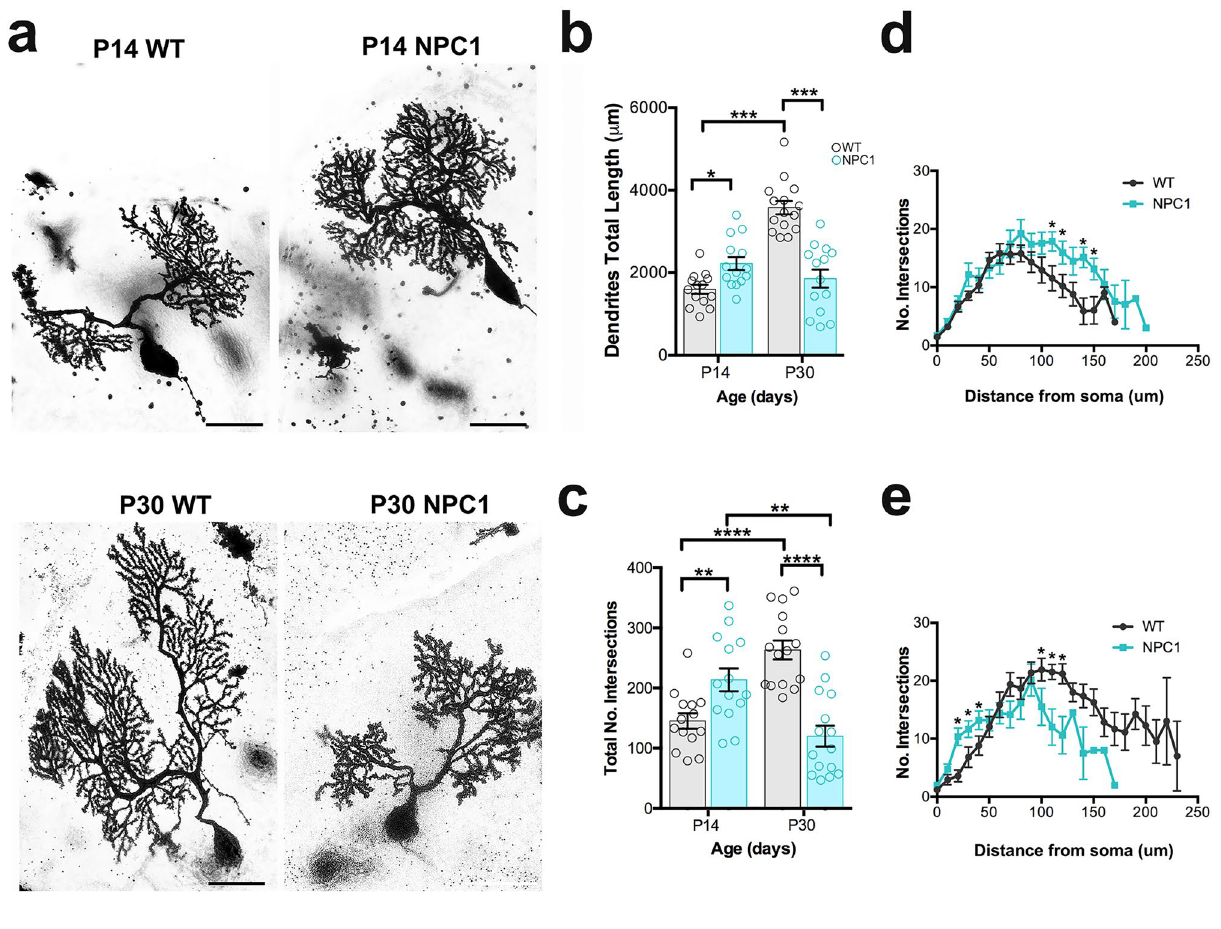
Figure 1. NPC1 deficiency alters the postnatal development of PC dendrites and synapses. ( a ) Golgi-Cox staining of PCs from WT and Npc1 nmf164 (NPC1) mice at P14 and P30. ( b ) Measurement of dendrites total length from PCs at P14 and P30 showing significant differences between WT and Npc1 nmf164 mice. Data are presented as mean ± SEM, n = 4 mice/genotype/age, 4–5 cells/mouse. ( c ) Measurement of total number of intersections calculated by Sholl analysis from PCs at P14 and P30 showing significant differences between WT and Npc1 nmf164 mice. Data are presented as mean ± SEM, n = 4 mice/genotype/age, 4–5 cells/mouse. ( d ) Sholl-analysis showing differences in PC dendritic branching between WT and Npc1 nmf164 mice at P14. ( e ) Sholl-analysis showing differences in PC dendritic branching between WT and Npc1 nmf164 mice at P30. ( e ) Interactions between GFP + PC dendritic spines and VGLUT1 + presynaptic terminals in WT and Npc1 nmf164 mice at P14 and P21. Arrowheads showing VGLUT1 (+) GFP + spines, arrows showing VGLUT1 (−) GFP + spines. ( f ) Quantitative analysis of the total number of spines per μm. ( g ) Quantitative analysis of the number of spines that are contacted by VGLUT1 + presynaptic terminals. ( h ) Quantitative analysis of the number of spines that are not contacted (VGLUT1 (−) ) by VGLUT1 + presynaptic terminals. Data are presented as mean ± SEM, n = 3–4